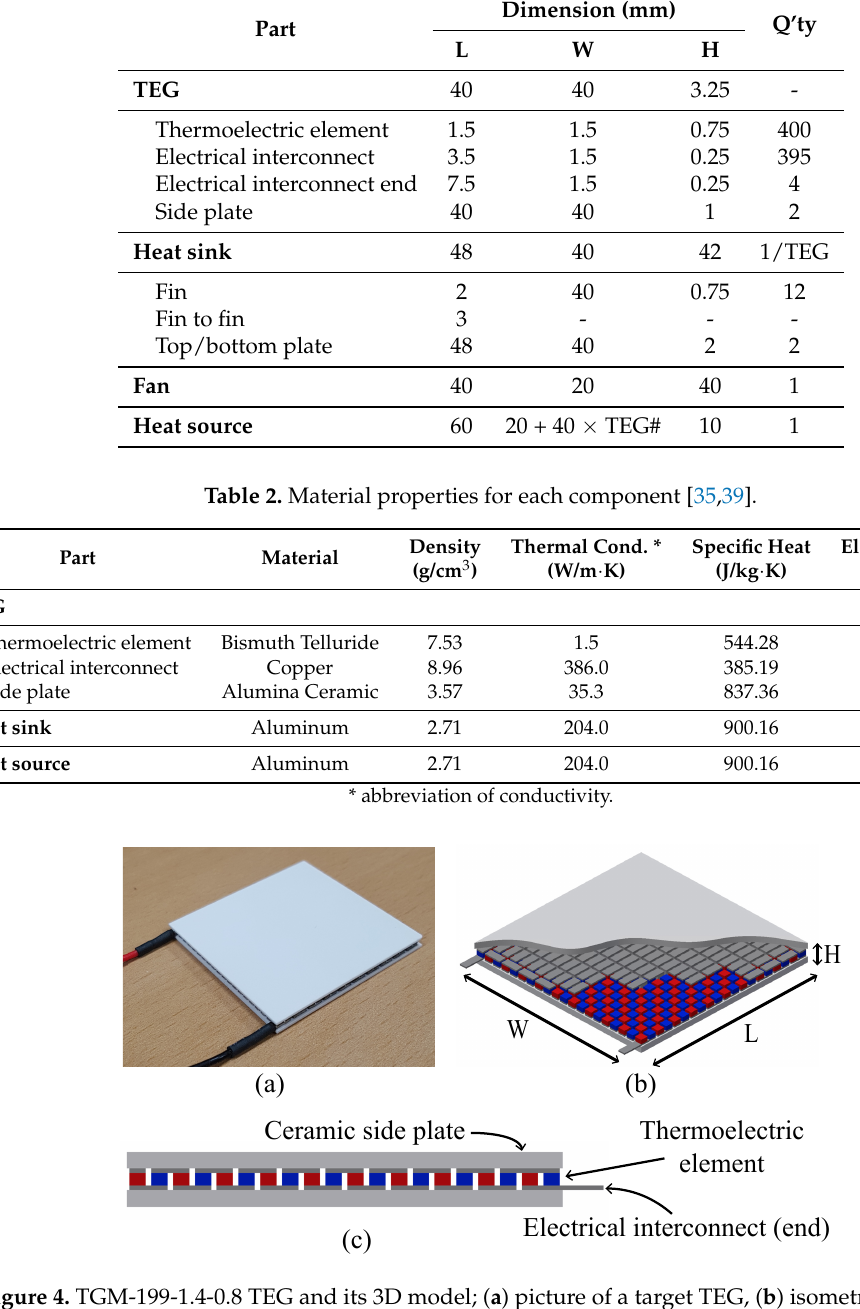
Figure 4. TGM-199-1.4-0.8 TEG and its 3D model; ( a ) picture of a target TEG, ( b ) isometric view of a target TEG 3D model, and ( c ) side view of a target TEG 3D